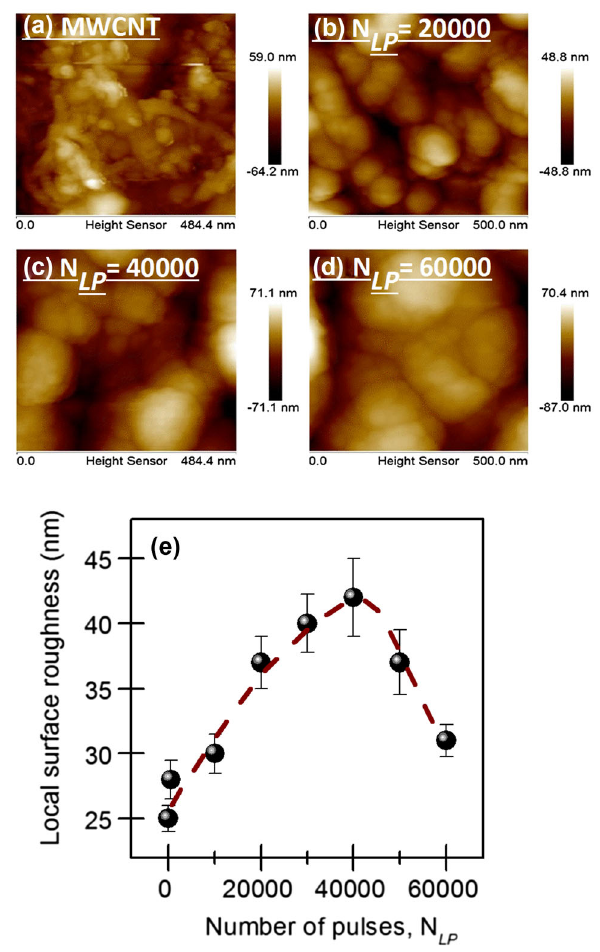
Fig. 2 2D-view of AFM images of a pristine MWCNTs and MWCNTs PLD-coated with Co–Ni NPs layer with b N LP = 20,000, c N LP = 40,000, d N LP = 60,000; e Variation of local surface roughness of the PLD-coated Co–Ni NPs layer after their decoration on to the MWCNTs as a function of N